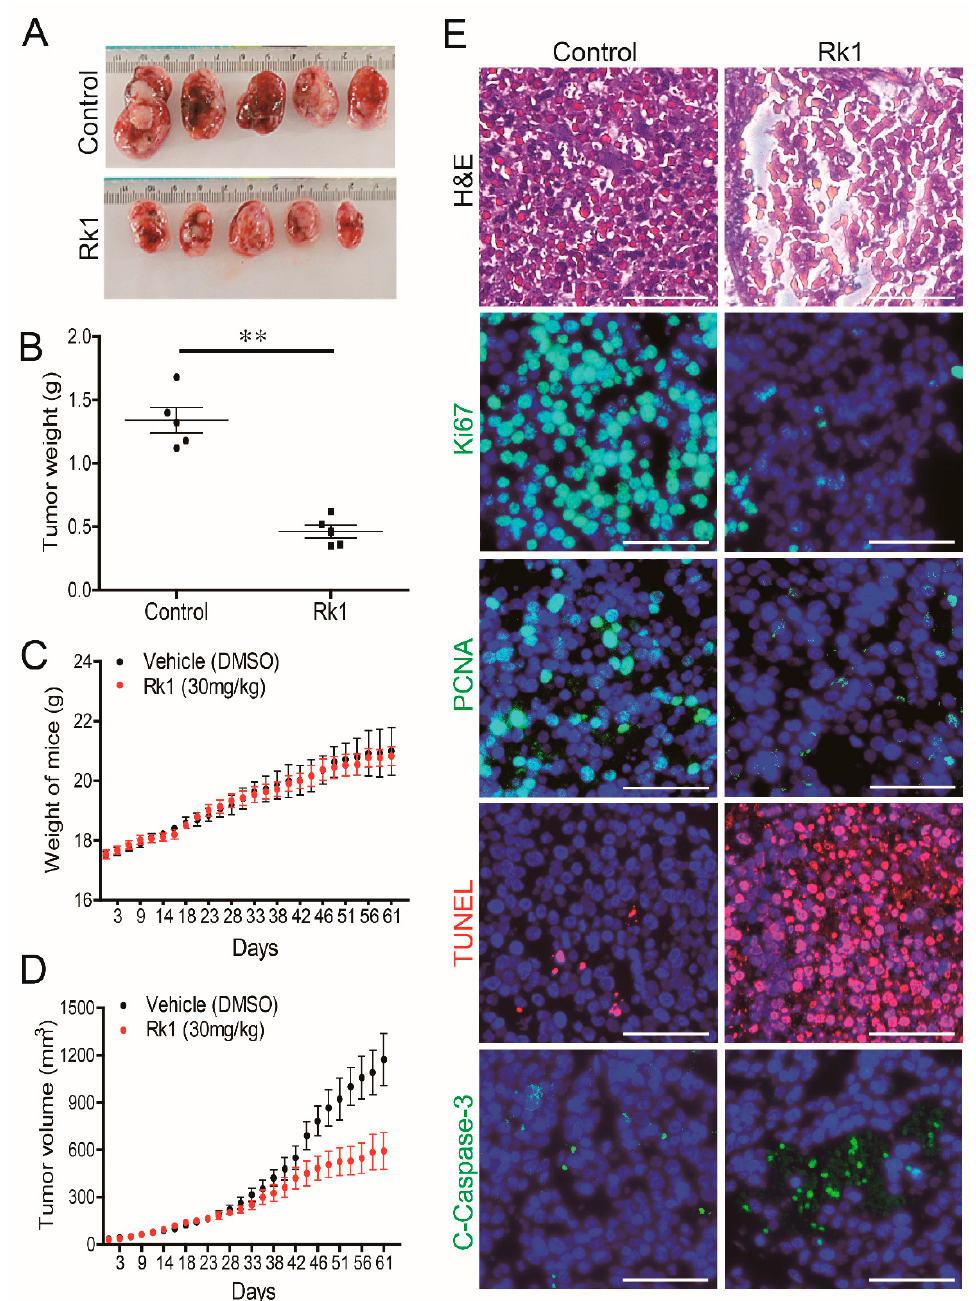
Figure 6. Rk1 reduces neuroblastoma growth in a xenograft mouse model. ( A ) Viable SK-N-BE(2) cells (3 × 10 7 ) were subcutaneously injected into the flanks of nu/nu mice. After a week, mice were administered either vehicle (DMSO; n = 5) or Rk1 (30 mg/kg; n = 5) via intraperitoneal injection three times a week. Mice were sacrificed and tumors were collected 61 days after cell injection ( B – D ) tumor weight ( B ), mouse weight ( C ) and tumor growth ( D ) curve following Rk1 treatment (30 mg/kg) or vehicle control in SK-N-BE(2) xenografts. The statistical analysis of body weight, tumor weight and tumor volume are shown (* p < 0.05 and * p <0.01). ( E ) H&E staining in subcutaneous tumor samples. Ki-67, PCNA, TUNEL and C-caspase-3 expression were detected by immunohistochmical staining in xenograft tumor tissues. Magnification of the images: 200 × . Scale bar: 50 µ